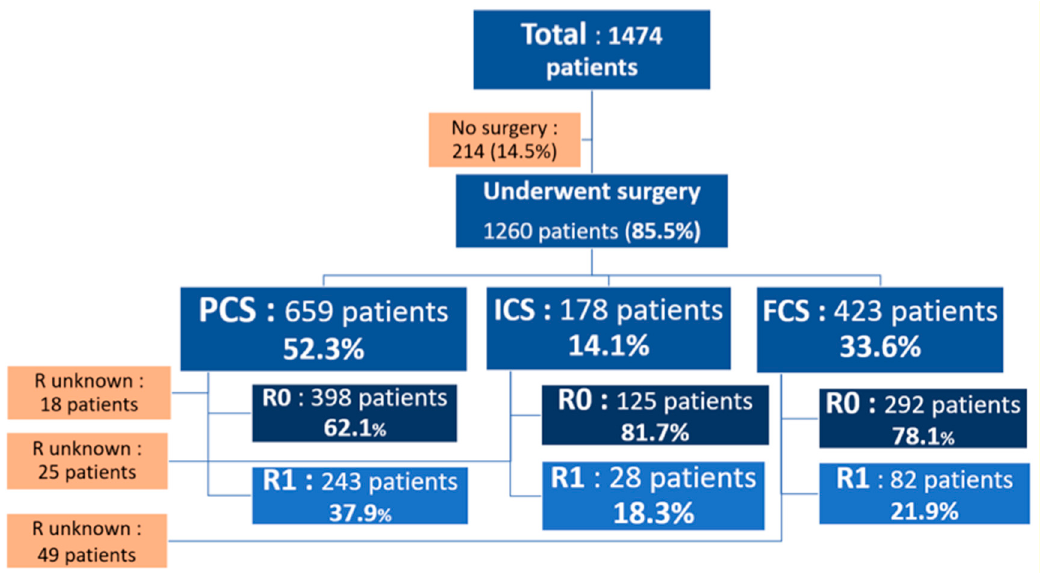
Figure A1. Flowchart. R0: complete resection of all visible disease, R1: remaining small volume of residual